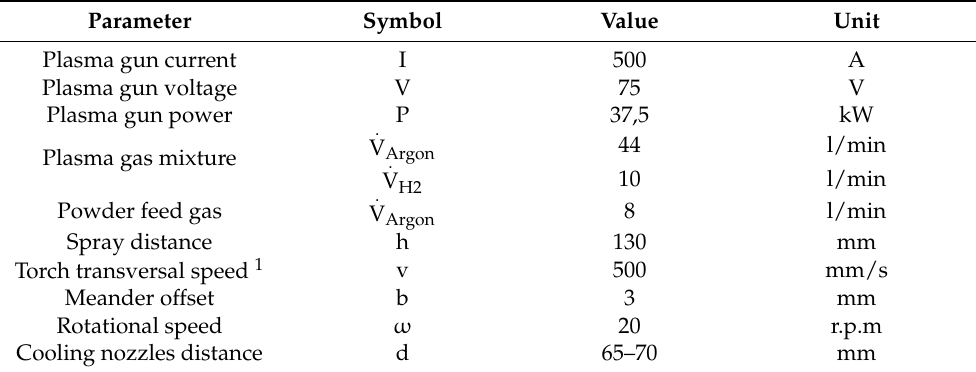
Table 3. Optimized spray plasma spray parameter set used in coating operation of the